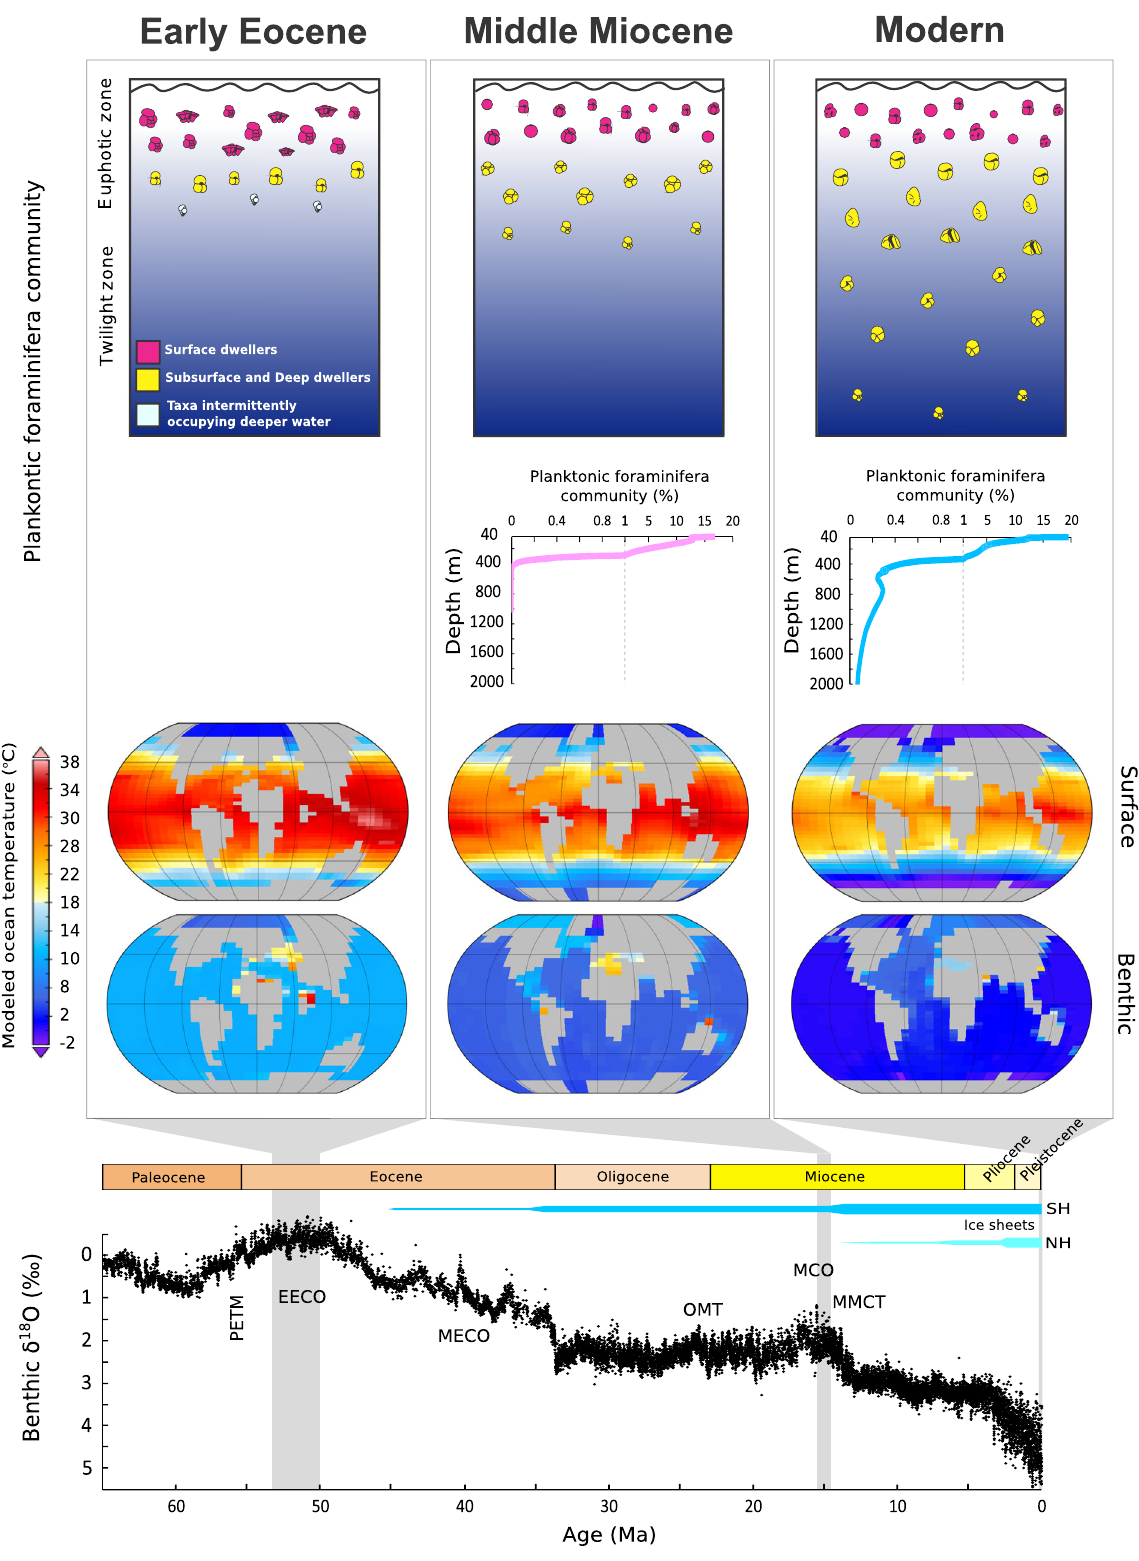
Fig. 1 | Foraminiferal data and climate indicators for the early Eocene, mid- Miocene, and preindustrial present. From the top: Illustrations of planktonic foraminiferal distribution and species diversity across the Cenozoic; Planktonic foraminiferal community distribution for the Miocene (pink) and core-top (blue) from ref. 8 (no data available for the early Eocene); modeled surface and benthic ocean temperature and continental con fi gurations for early Eocene, mid-Miocene and preindustrial present ( “ Modern ” ); the global benthic δ 18 O stack for changes